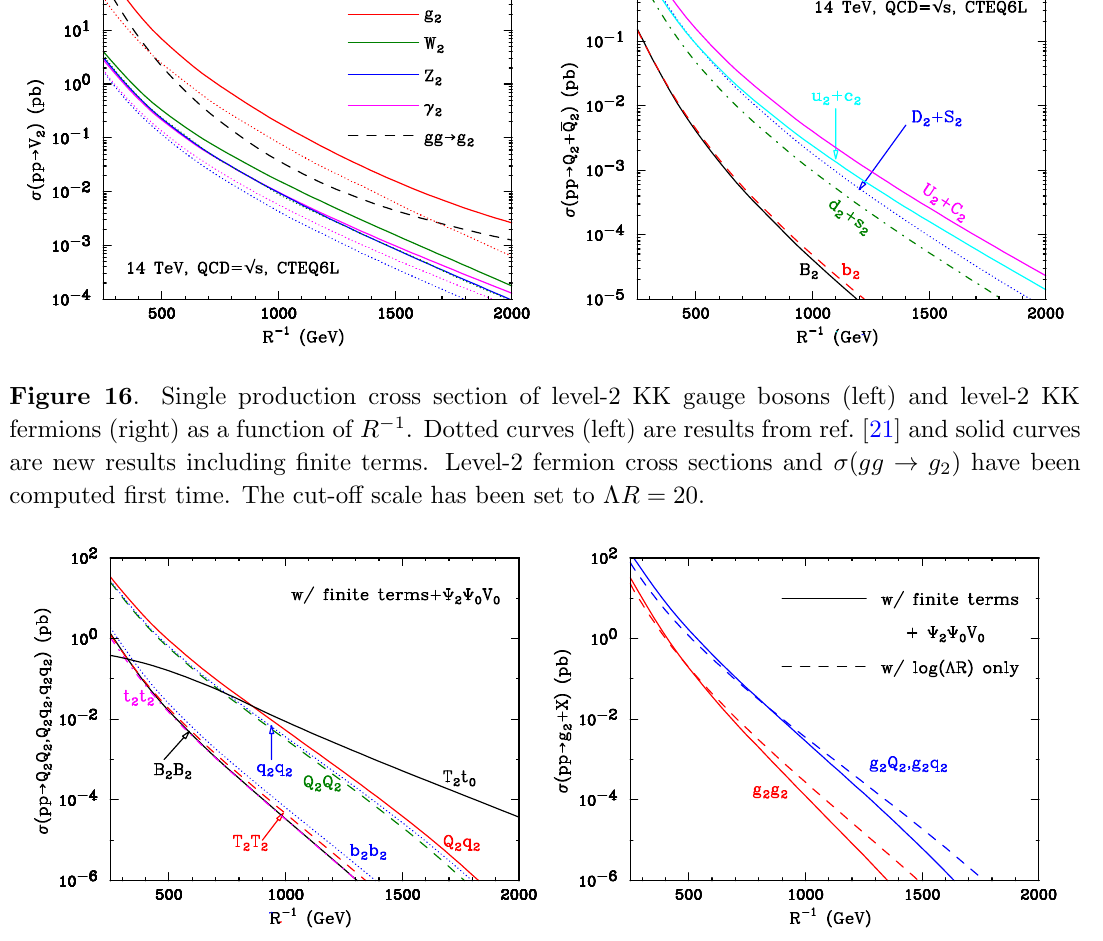
Figure 17 . Strong production of n = 2 KK particles at the 14 TeV LHC. The left panel shows KK-quark pair production, while the right panel shows KK-quark/KK-gluon associated production and KK gluon pair production. Updated results (solid curves) are similar to old results (in dashed curves from ref. [21]). The cut-o(cid:11) scale has been set to (cid:3) R =